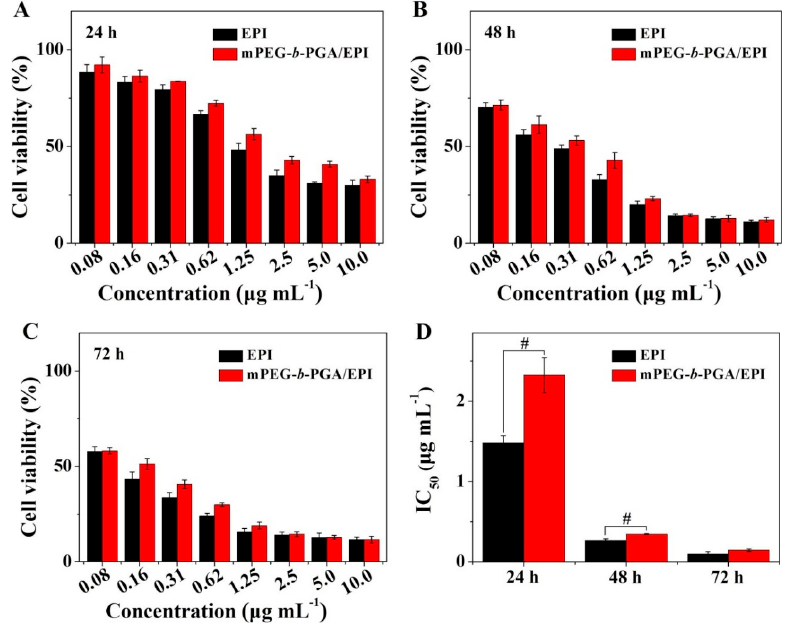
Figure 6. In vitro cytotoxicities of free EPI and mPEG- b -PGA/EPI toward HepG2 cells after incubation for 24 ( A ), 48 ( B ), or 72 h ( C ), and the corresponding IC 50 values ( D ). Data were presented as a mean ± SD ( n = 3; # p <